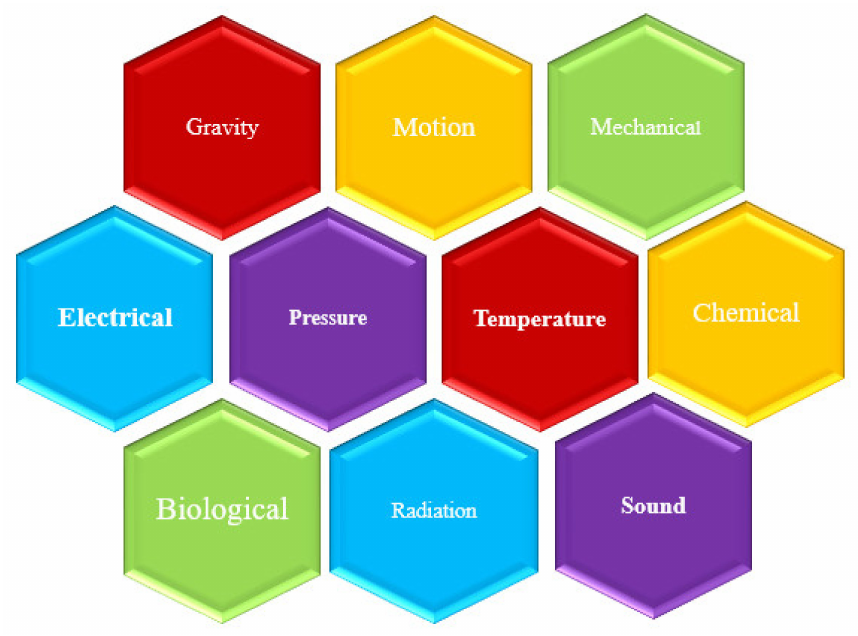
Figure 1. Schematic representation of visual cues, mental schemas, and energy-based